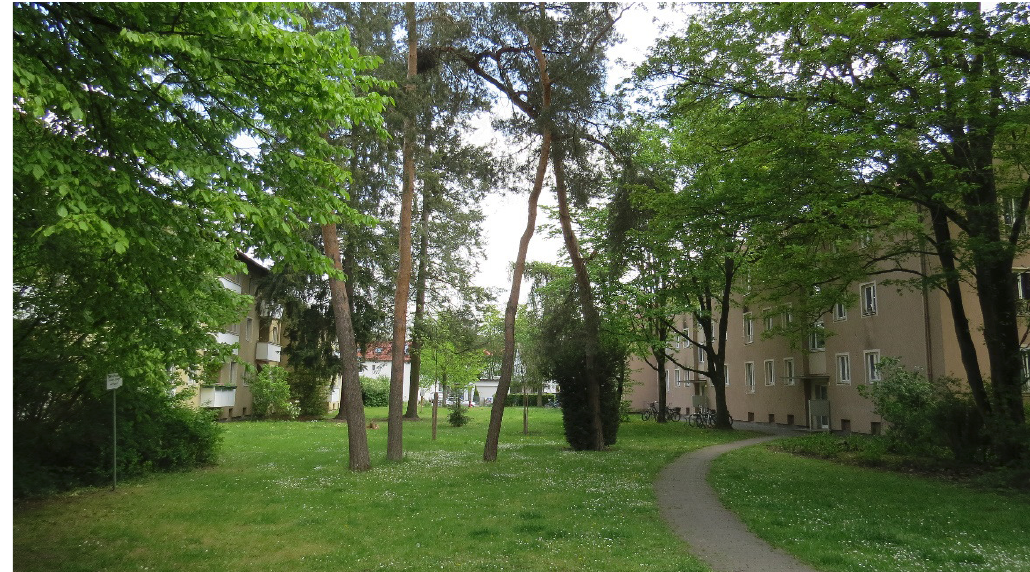
Figure 2. Typical workers’ housing estate as it still exists in the not‐yet‐redensified parts of the